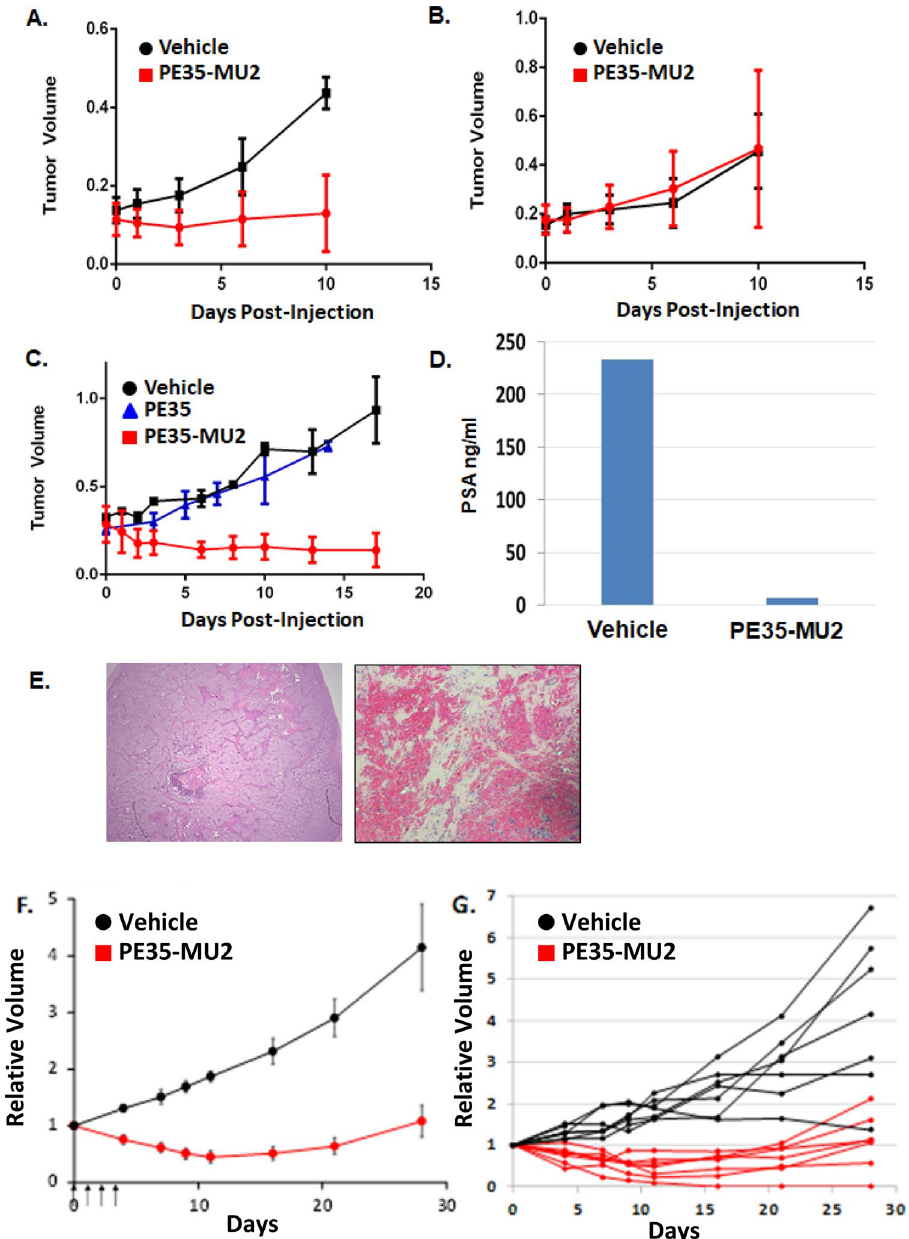
20 μg PE35-MU2 (* = p < 0.05). ( C ) LNCaP xenograft growth following two injections of either vehicle, 20 μg uncoupled PE35 or 20 μg PE35-MU2 (n = 7 each) (* = p < 0.05). ( D ) PSA levels determined via ELISA of LNCaP-bearing nude mice after 3 weeks of treatment. ( E ) H & E staining of an untreated LNCAaP tumor (left) versus a PE35-MU2-injected LNCaP tumor after 3 weeks treatment at (right) (10 ×). ( F ) Growth of LNCaP xenograft following four daily intravenous injections of 50 μg (2 mg/kg) PE35-MU2 (n = 7) versus vehicle (n = 7) ( p = < 0.05 at all time points by students t-test). ( G ) Growth curves for individual treated